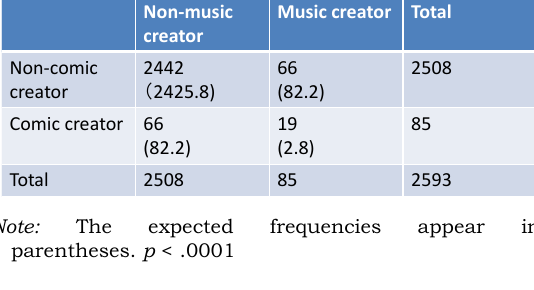
Table 2. Result of hypothesis 2 testing